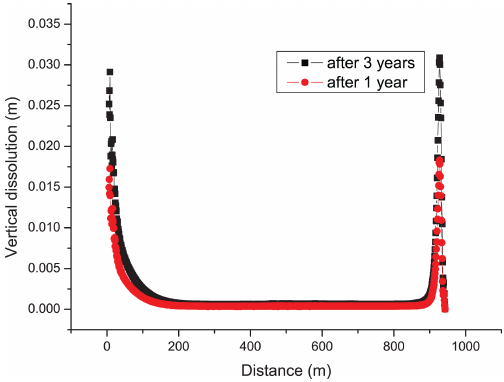
Figure 4. Amount of vertical dissolution over each element after 1 and 3years of simulation with 10m fault